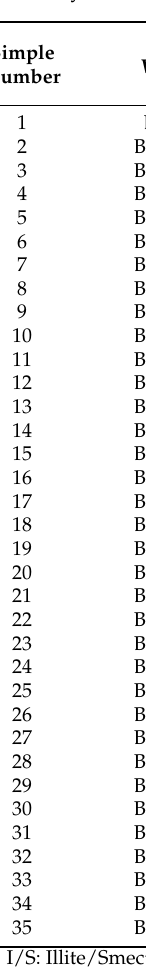
Table 1. Clay mineral composition base on XRD